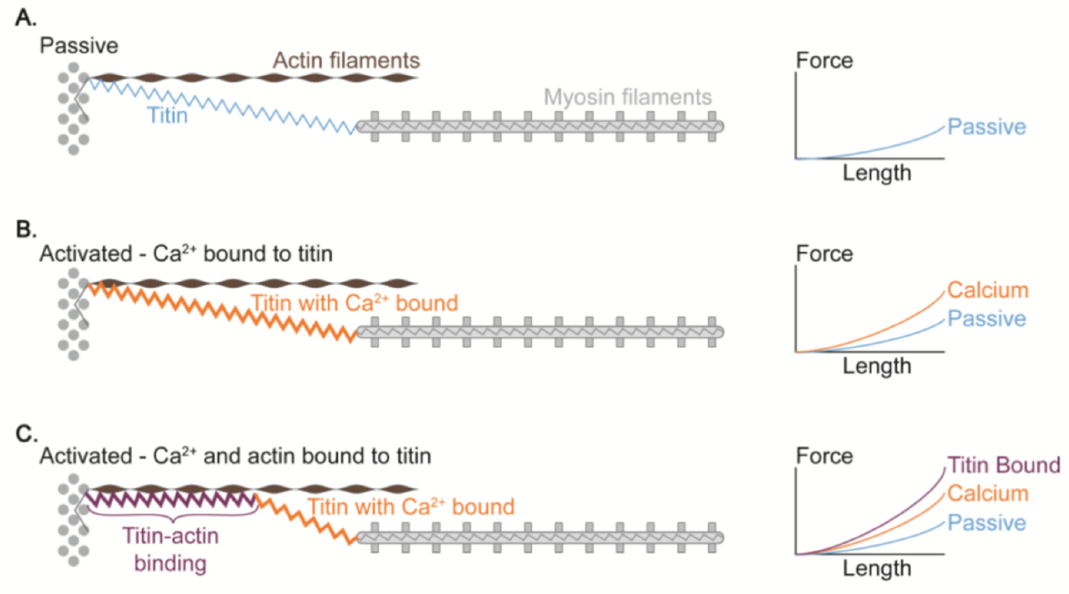
Figure 8. Proposed mechanism of titin-actin interaction [63]. Compared to the normal condition A (i.e., no Ca 2+ and no titin-actin binding), the passive force is greater in the Ca 2+ -induced stiff titin condition B. This passive force is further increased when the titin is attached to the actin because the titin stiffness and force at a given sarcomere length should increase (condition C).